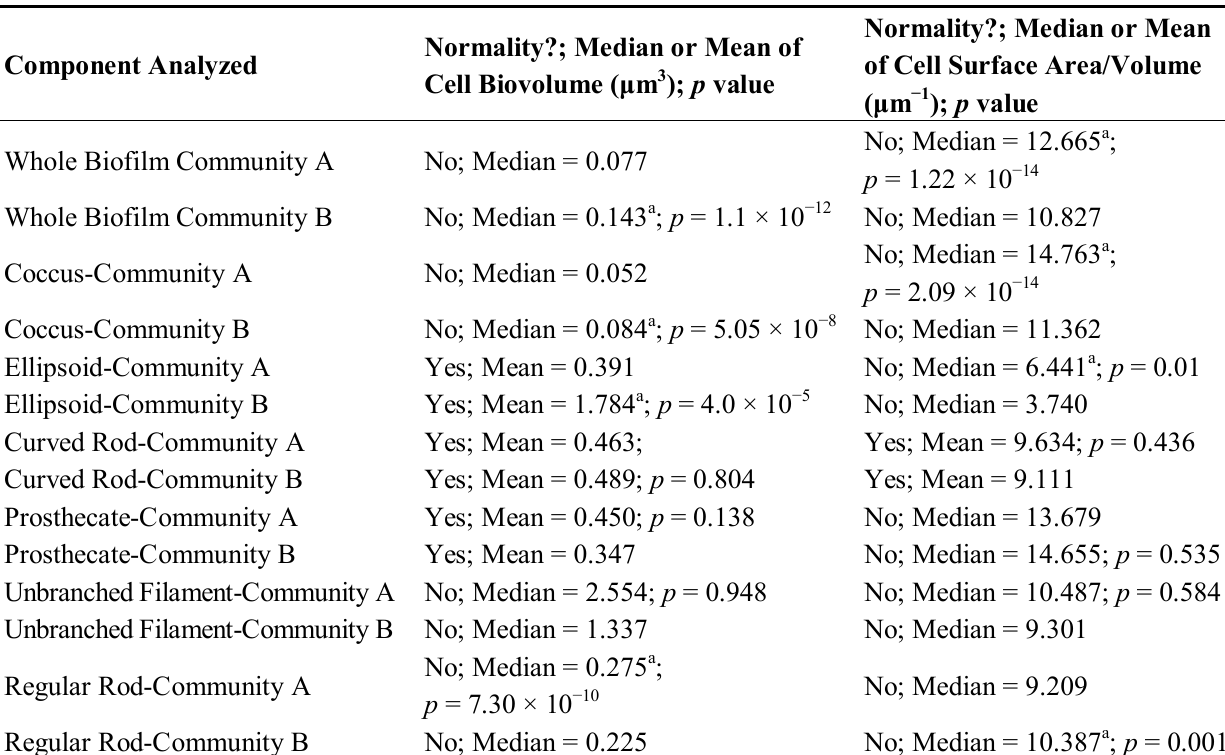
Table 4. Tests for normality and differences between mean or median of individual cell biovolumes and surface area/biovolume ratio for microbial morphotype classes in communities A and B. The superscript a denotes higher values (Community A vs. Community B) that are statistically significant at the indicated p level, based on the appropriate 2-tailed Student t (for mean) or Mann-Whitney (for median) inference tests. Normality?; Median or Mean Component Analyzed